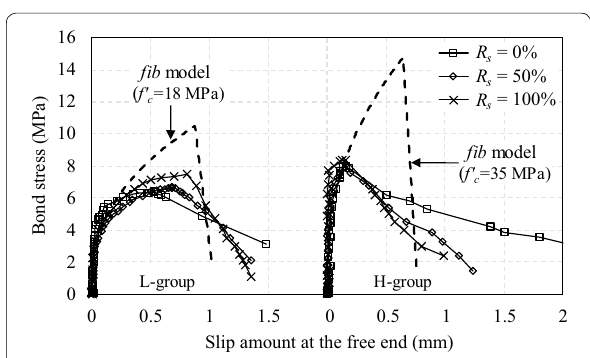
Fig. 12 Typical bond–slip behavior of the ribbed reinforcing bar embedded in the